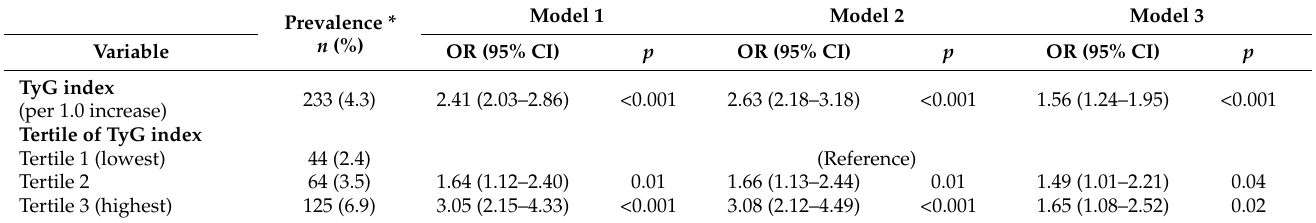
Table 2. Logistic regression analyses for albuminuria according to TyG